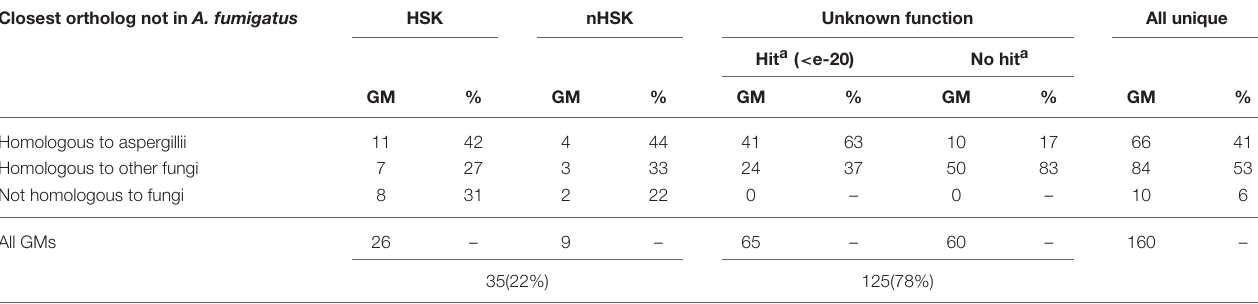
TABLE 4 | Half of the AFUMN unique GMs were from other non aspergillii